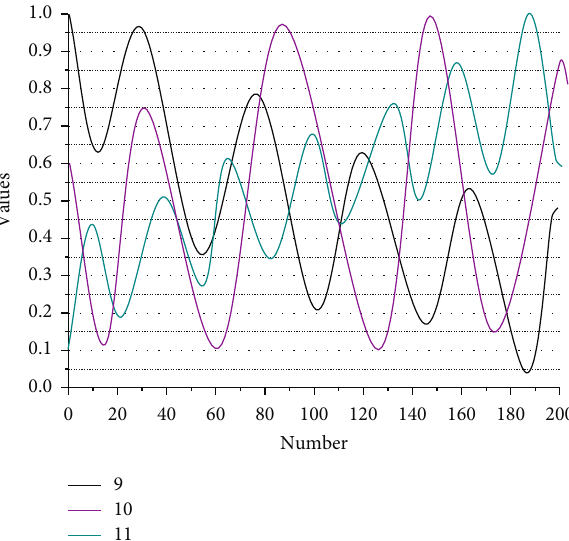
Figure 6: Q1 antitelco fraud big data report.